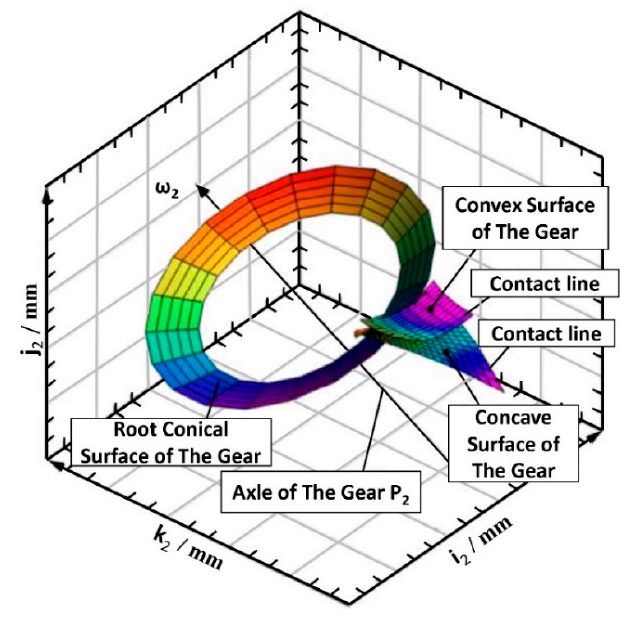
Figure 2. Theoretical Modeling of the gear concave and convex surfaces.